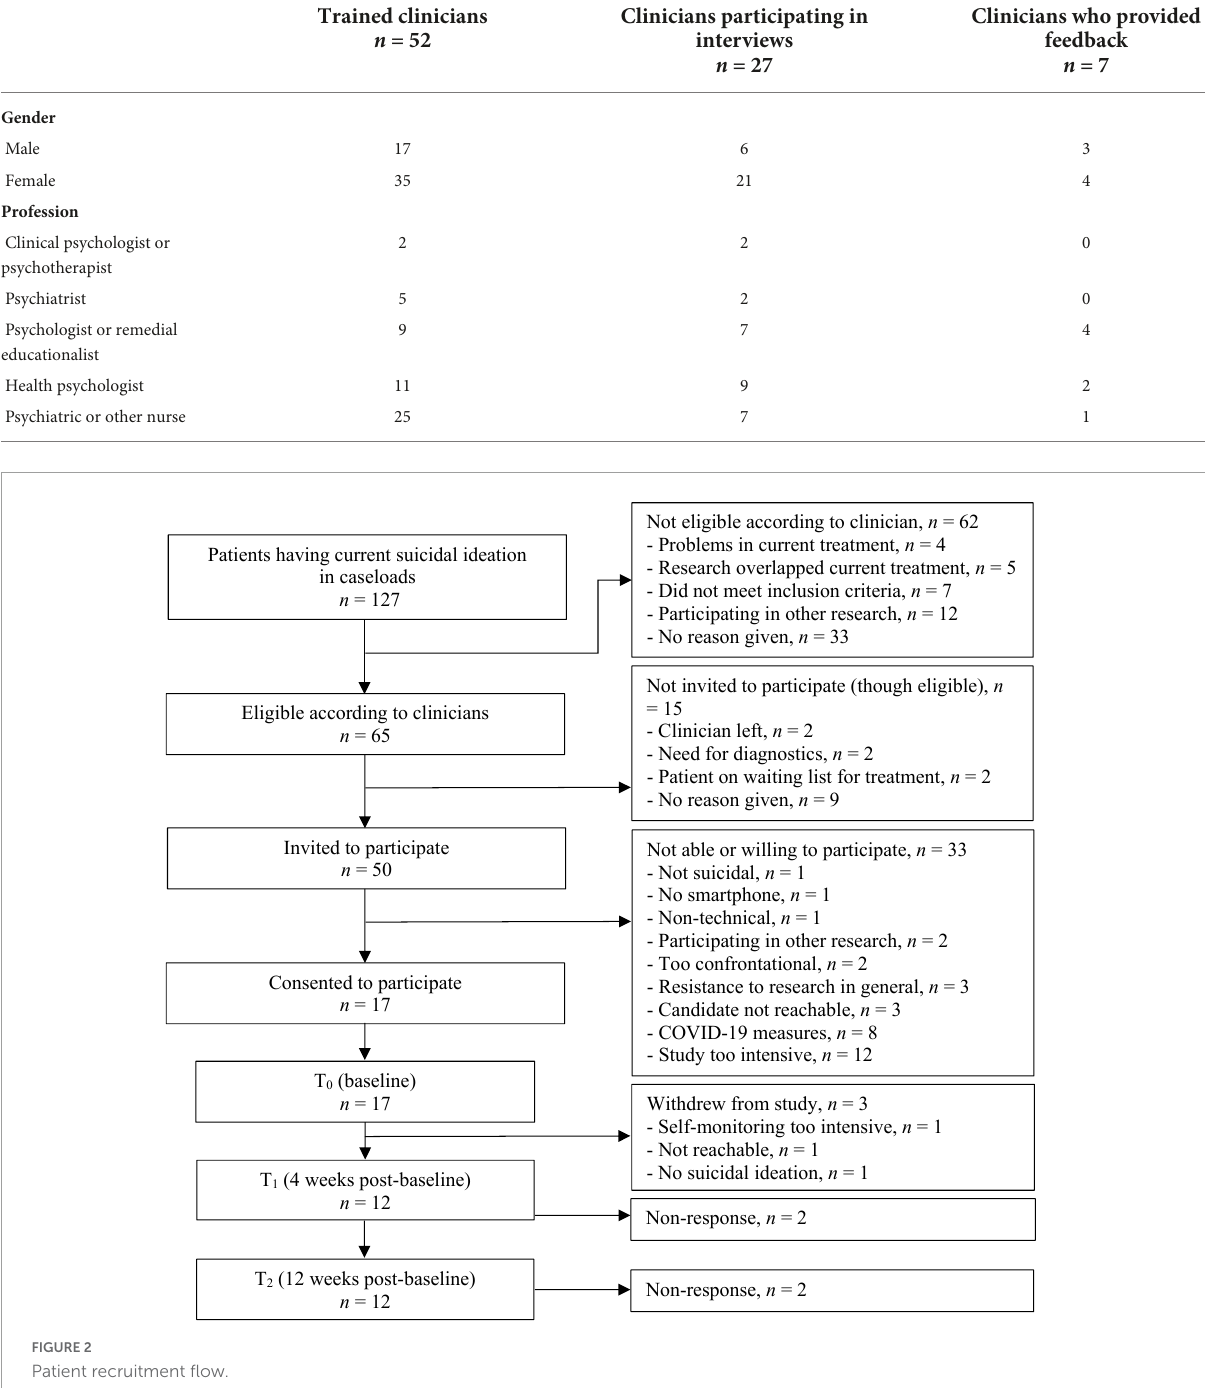
TABLE 1 Demographic characteristics of clinicians.